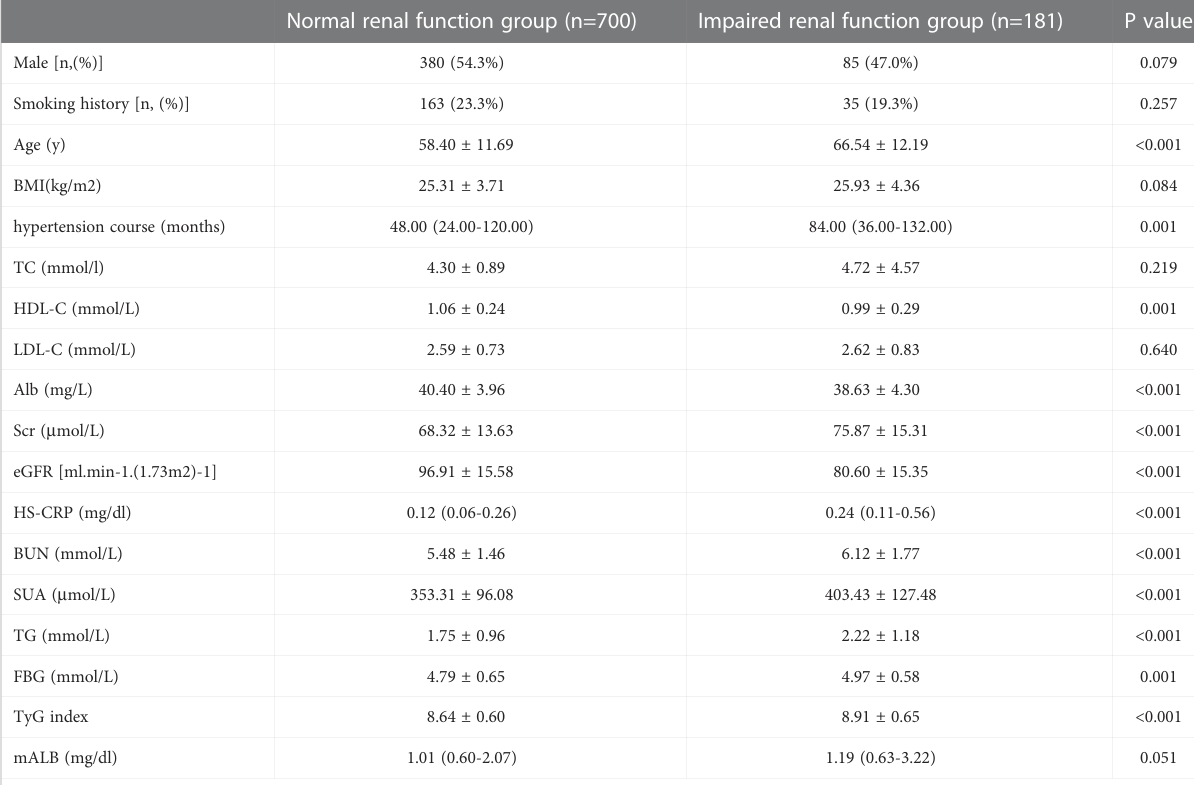
TABLE 3 Comparison of general data and clinical index between two groups on b 2-MG level. Normal renal function group